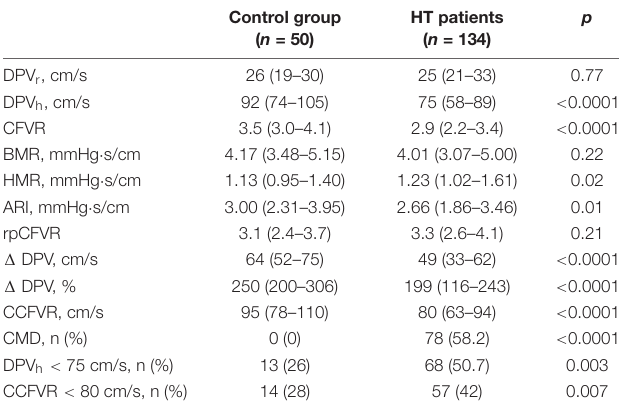
TABLE 1 | Microvascular coronary flow parameters in healthy subjects and heart transplant